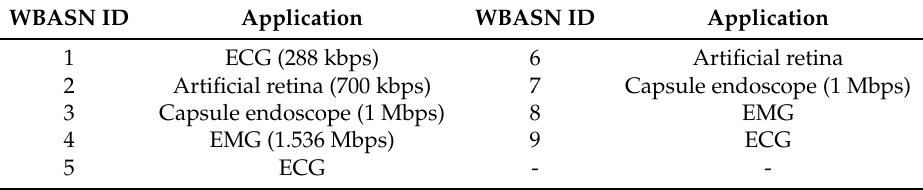
Table 5. Applications used by WBASNs in the performance-evaluation-with-entry